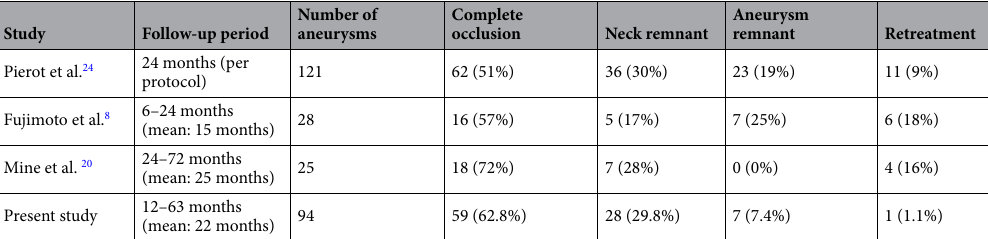
Table 3. Overview of studies reporting long-term outcome for the